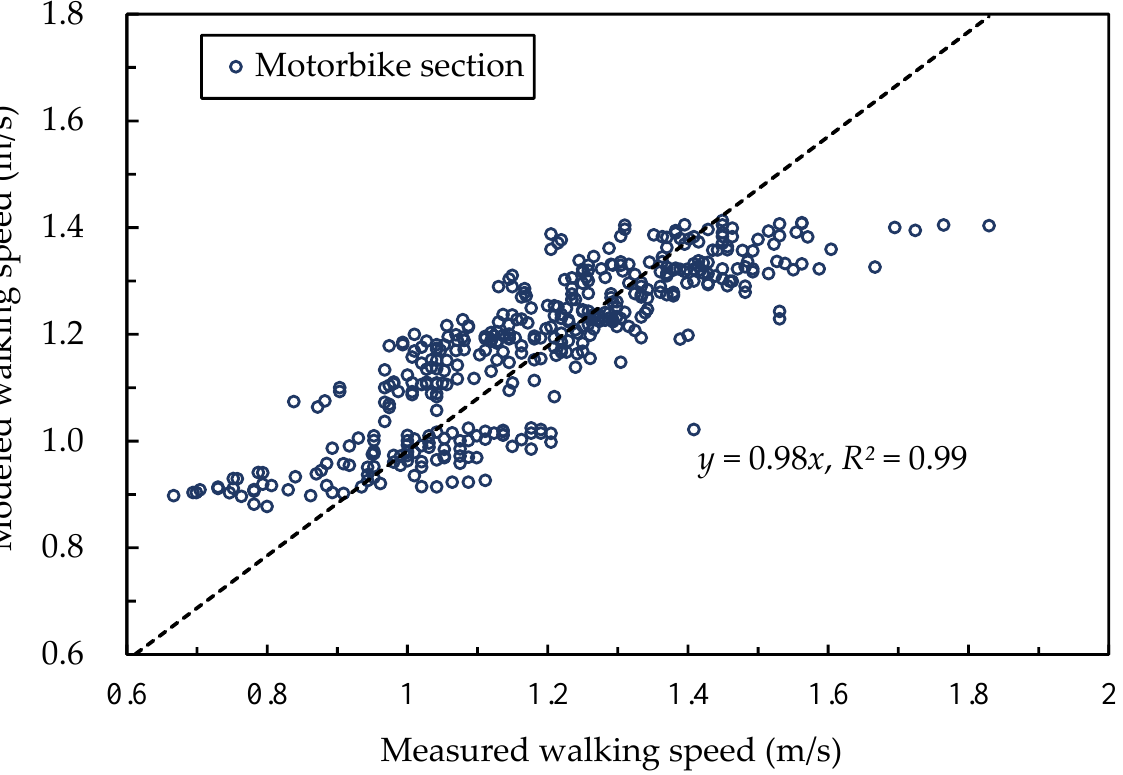
Figure 13. Measured walking speed and modeled walking speed.